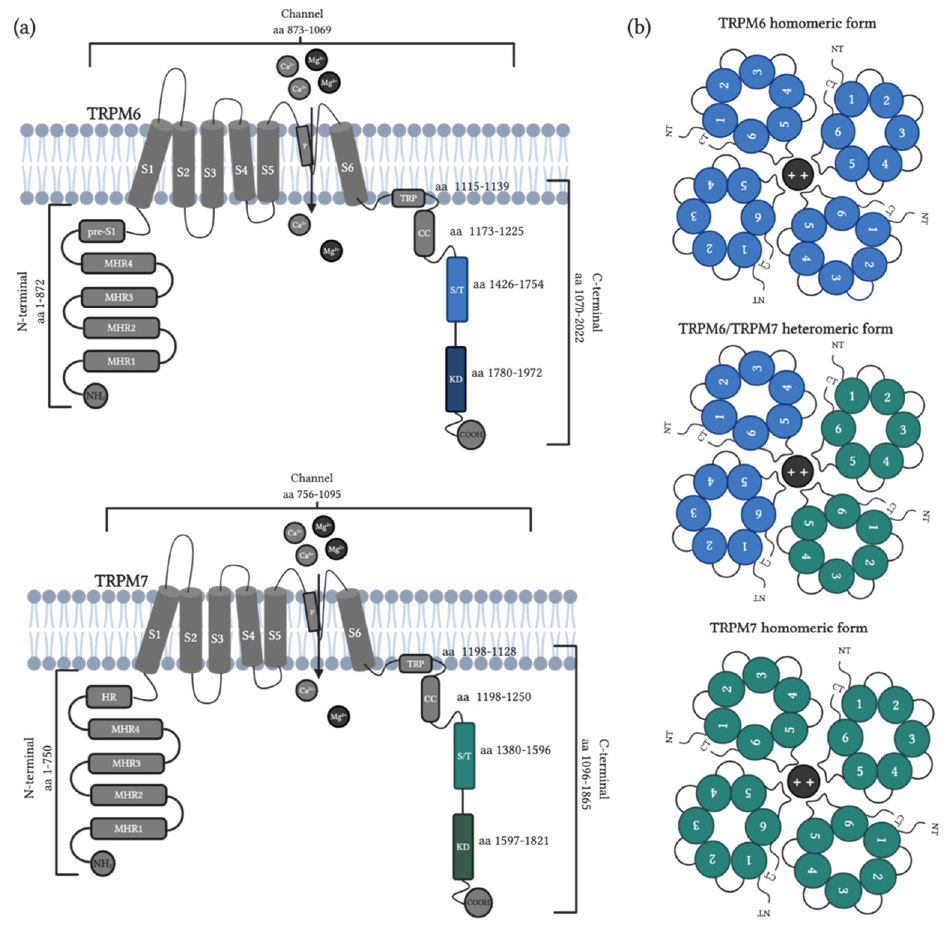
Figure 5. TRPM6 and TRPM7 structure and tetramer representation. ( a ) The N-terminus region is composed of four melastatin homology regions (MHR) and the pre-S1 (TRPM6) or homology region (HR, TRPM7) domain. The channel domain contains six transmembrane segments (S1–S6) and the pore-forming loop between the S5 and S6 segments. The C-terminus region is composed of TRP, coiled-coil (CC), Serine—Threonine (S / T) and kinase domains. aa: amino acid. ( b ) These channels form tetramers with four subunits in homomeric or heteromeric form forming a pore in the membrane and allows divalent cations to permeate. 1–6: transmembrane subunits, NT: N-terminus, CT: C-terminus. Created with BioRender.com.